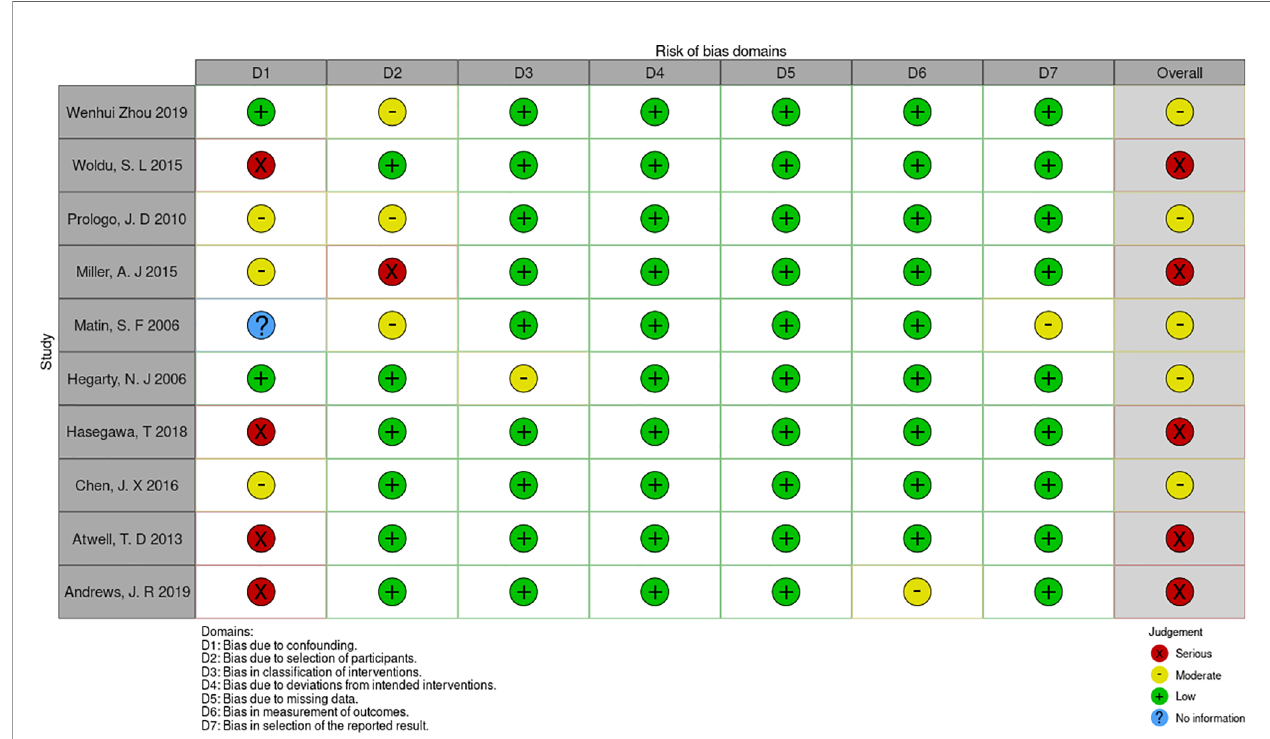
FIGURE 2 | the risk of bias assessment for each trial using the non-randomized studies of interventions (ROBINS-I).